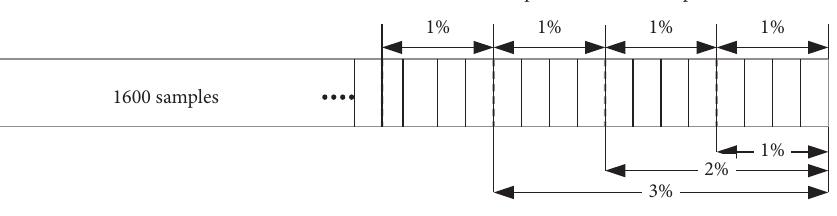
Figure 10: The additional rules for label samples.